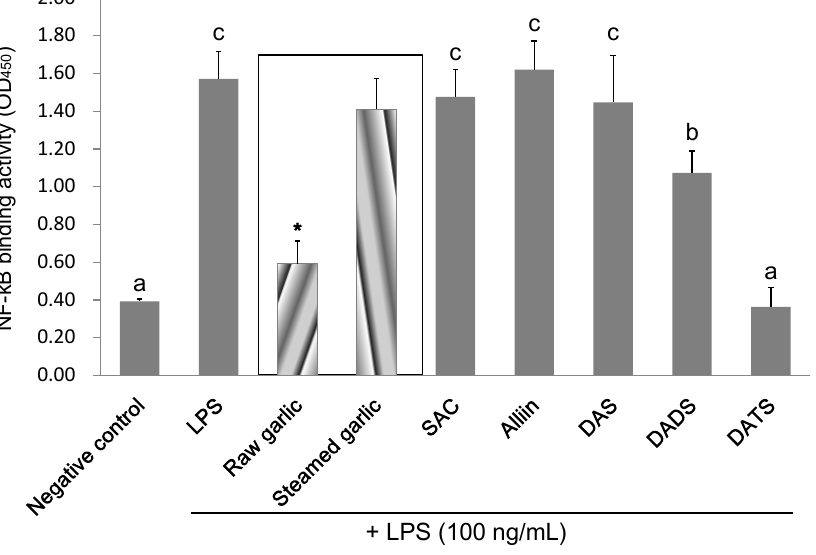
LPS-activated BV2 microglia. The treatment concentration is 5 mg/mL for garlic extracts; 1000 µM for SAC, alliin and DAS; 400 µM for DADS; and 200 µM for DATS. The values are expressed as means ± SD of triplicate tests. Means not sharing a common letter were significantly different ( p < 0.05) when analyzed by ANOVA and Duncan’s multiple range test. * indicates that tested sample is significantly different from LPS ( p < 0.05).